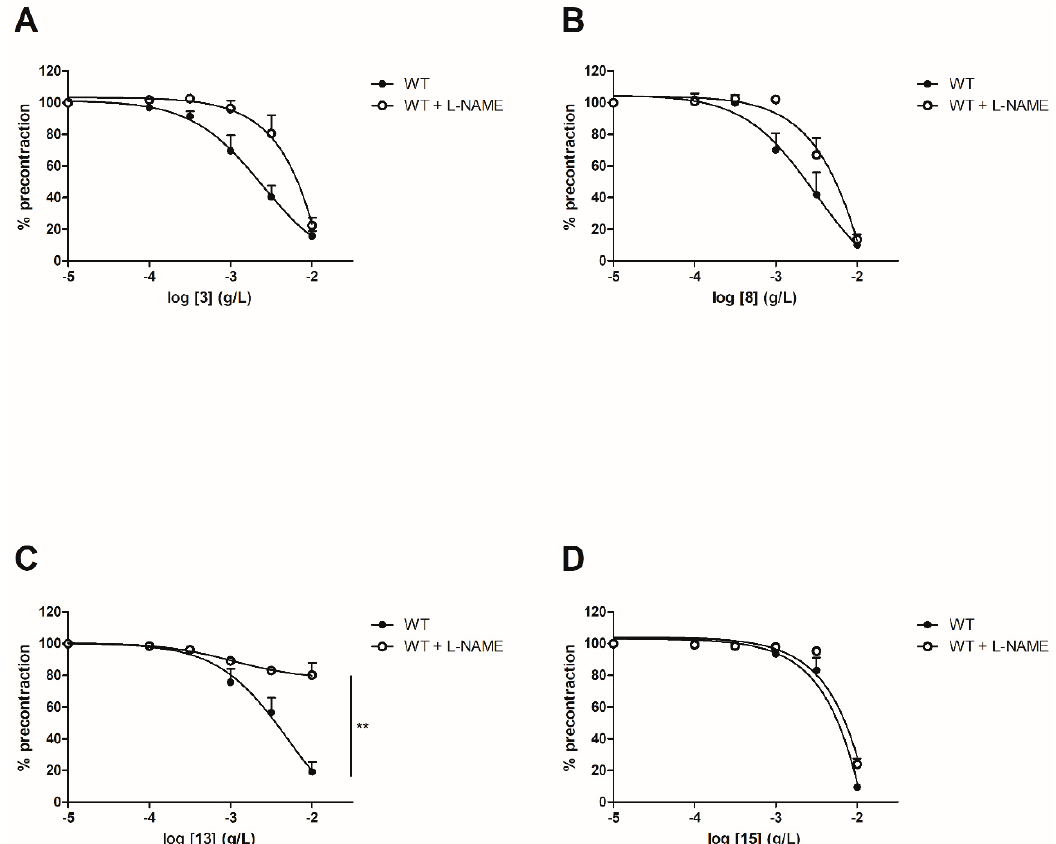
Figure 4. Concentration-response curves for the vasorelaxation effect on WT mice thoracic aorta of synthetic chalcones 3 ( A ), 8 ( B ), 13 ( C ) and 15 ( D ) in the presence or in absence of L-NAME, a selective eNOS inhibitor. Mice were ovariectomized 7 days before the experiment. Vessels were pre-contracted with U46619, phenylephrine, and serotonin, at 80 % of their maximal response. The presence of functional endothelium was assessed by determining the ability of acetylcholine (10 µM) to induce more than 50% relaxation of pre-contracted rings. Results are expressed in percentage of precontraction (y-axis) following the concentration (x-axis). L-NAME only prevented the chalcone-induced vasorelaxation for the synthetic chalcone 13 at the highest concentration (10 -2 g/L) and seemed to prevent the chalcone-induced vasorelaxation for compounds 3 and 8 at low concentrations. No difference was observed for chalcone 15 . N = 5–7, ** p < 0.01 (Mann-Whitney).